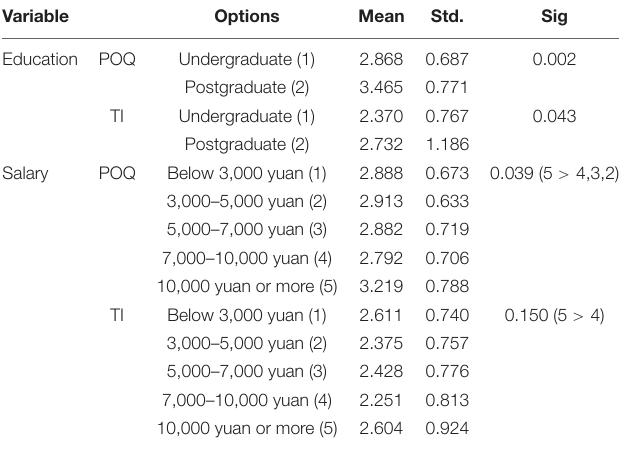
TABLE 5 | Results of one-way ANOVA